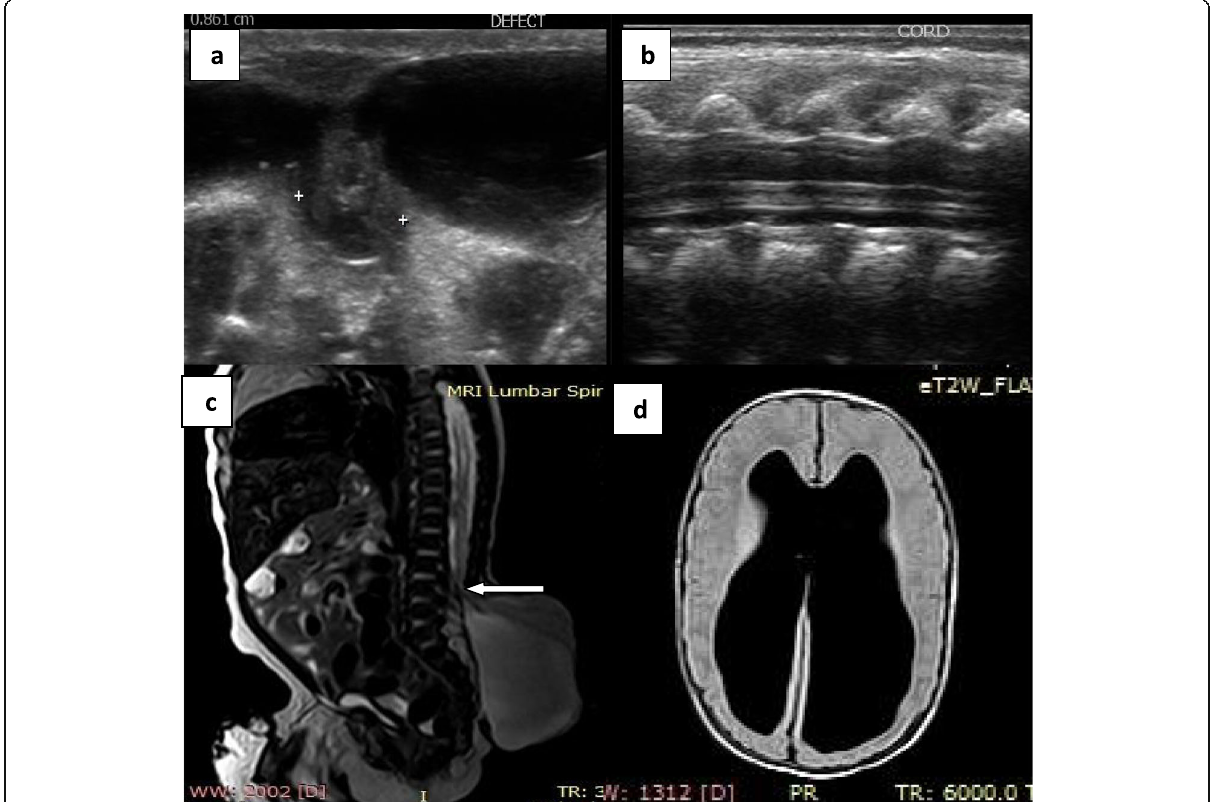
Fig. 2 Thirty-five-day-old infant presented with a large lumbar cystic swelling and paraplegia. a Transverse USG showed defective spinous process with CSF and nerve roots passing through it. b Longitudinal USG showed dilatation of central spinal canal with fluid (hydromyelia). c Sagittal STIR MRI showed defective spinous processes ( white arrow ), large lumbar swelling with CSF and nerve roots (myelomeningocele), and high signal fluid intensity noted within the spinal cord in keeping with syringohydromyelia ( arrow ). d Axial FLAIR MRI of brain showed hydrocephalus (Chiari II). Final diagnosis is Arnold-Chiari II Syndrome (myelomeningocele with syringohydromyelia and hydrocephalus), agreement frequency between ultrasound and MRI findings =